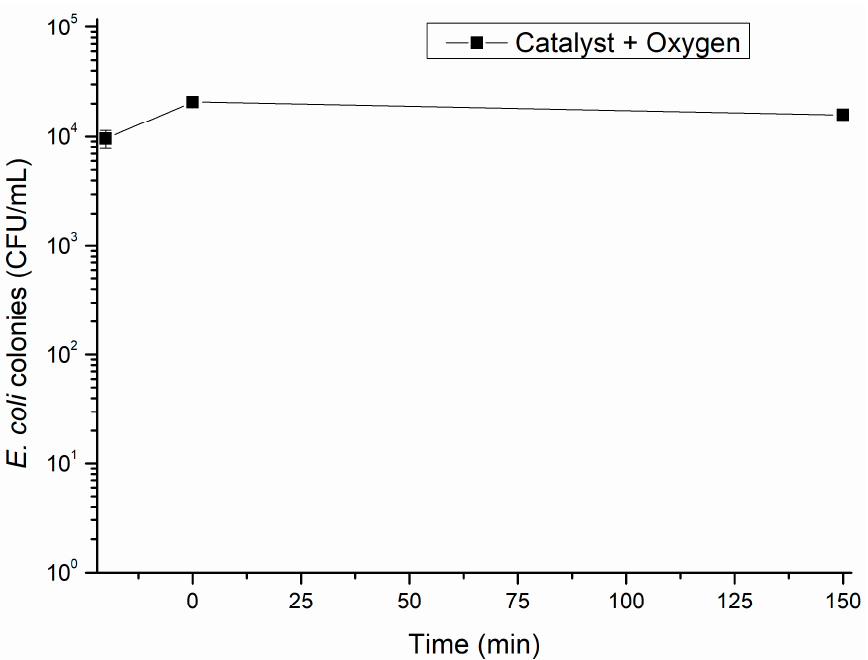
Figure 2. E. coli concentration using wastewater and volcanic rock as a function of time ( − 20 to 0 min without oxygen and from 0 min bubbling O 2 , using log 10 scale).